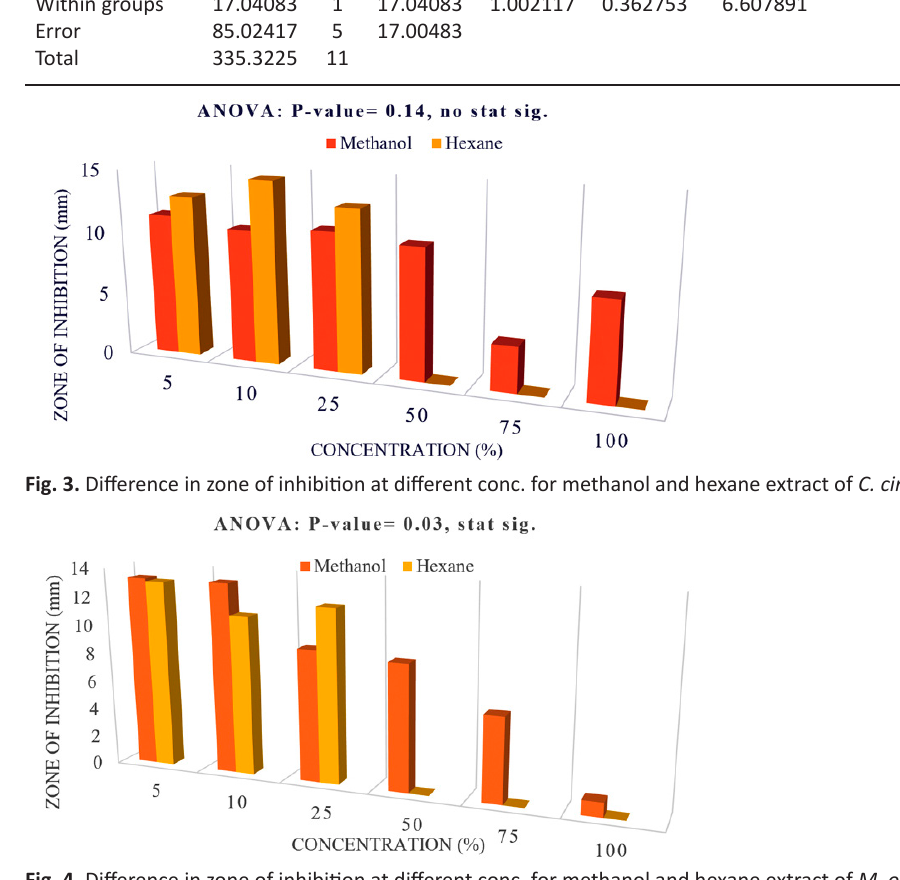
Fig. 4. Difference in zone of inhibition at different conc. for methanol and hexane extract of M. oleifera